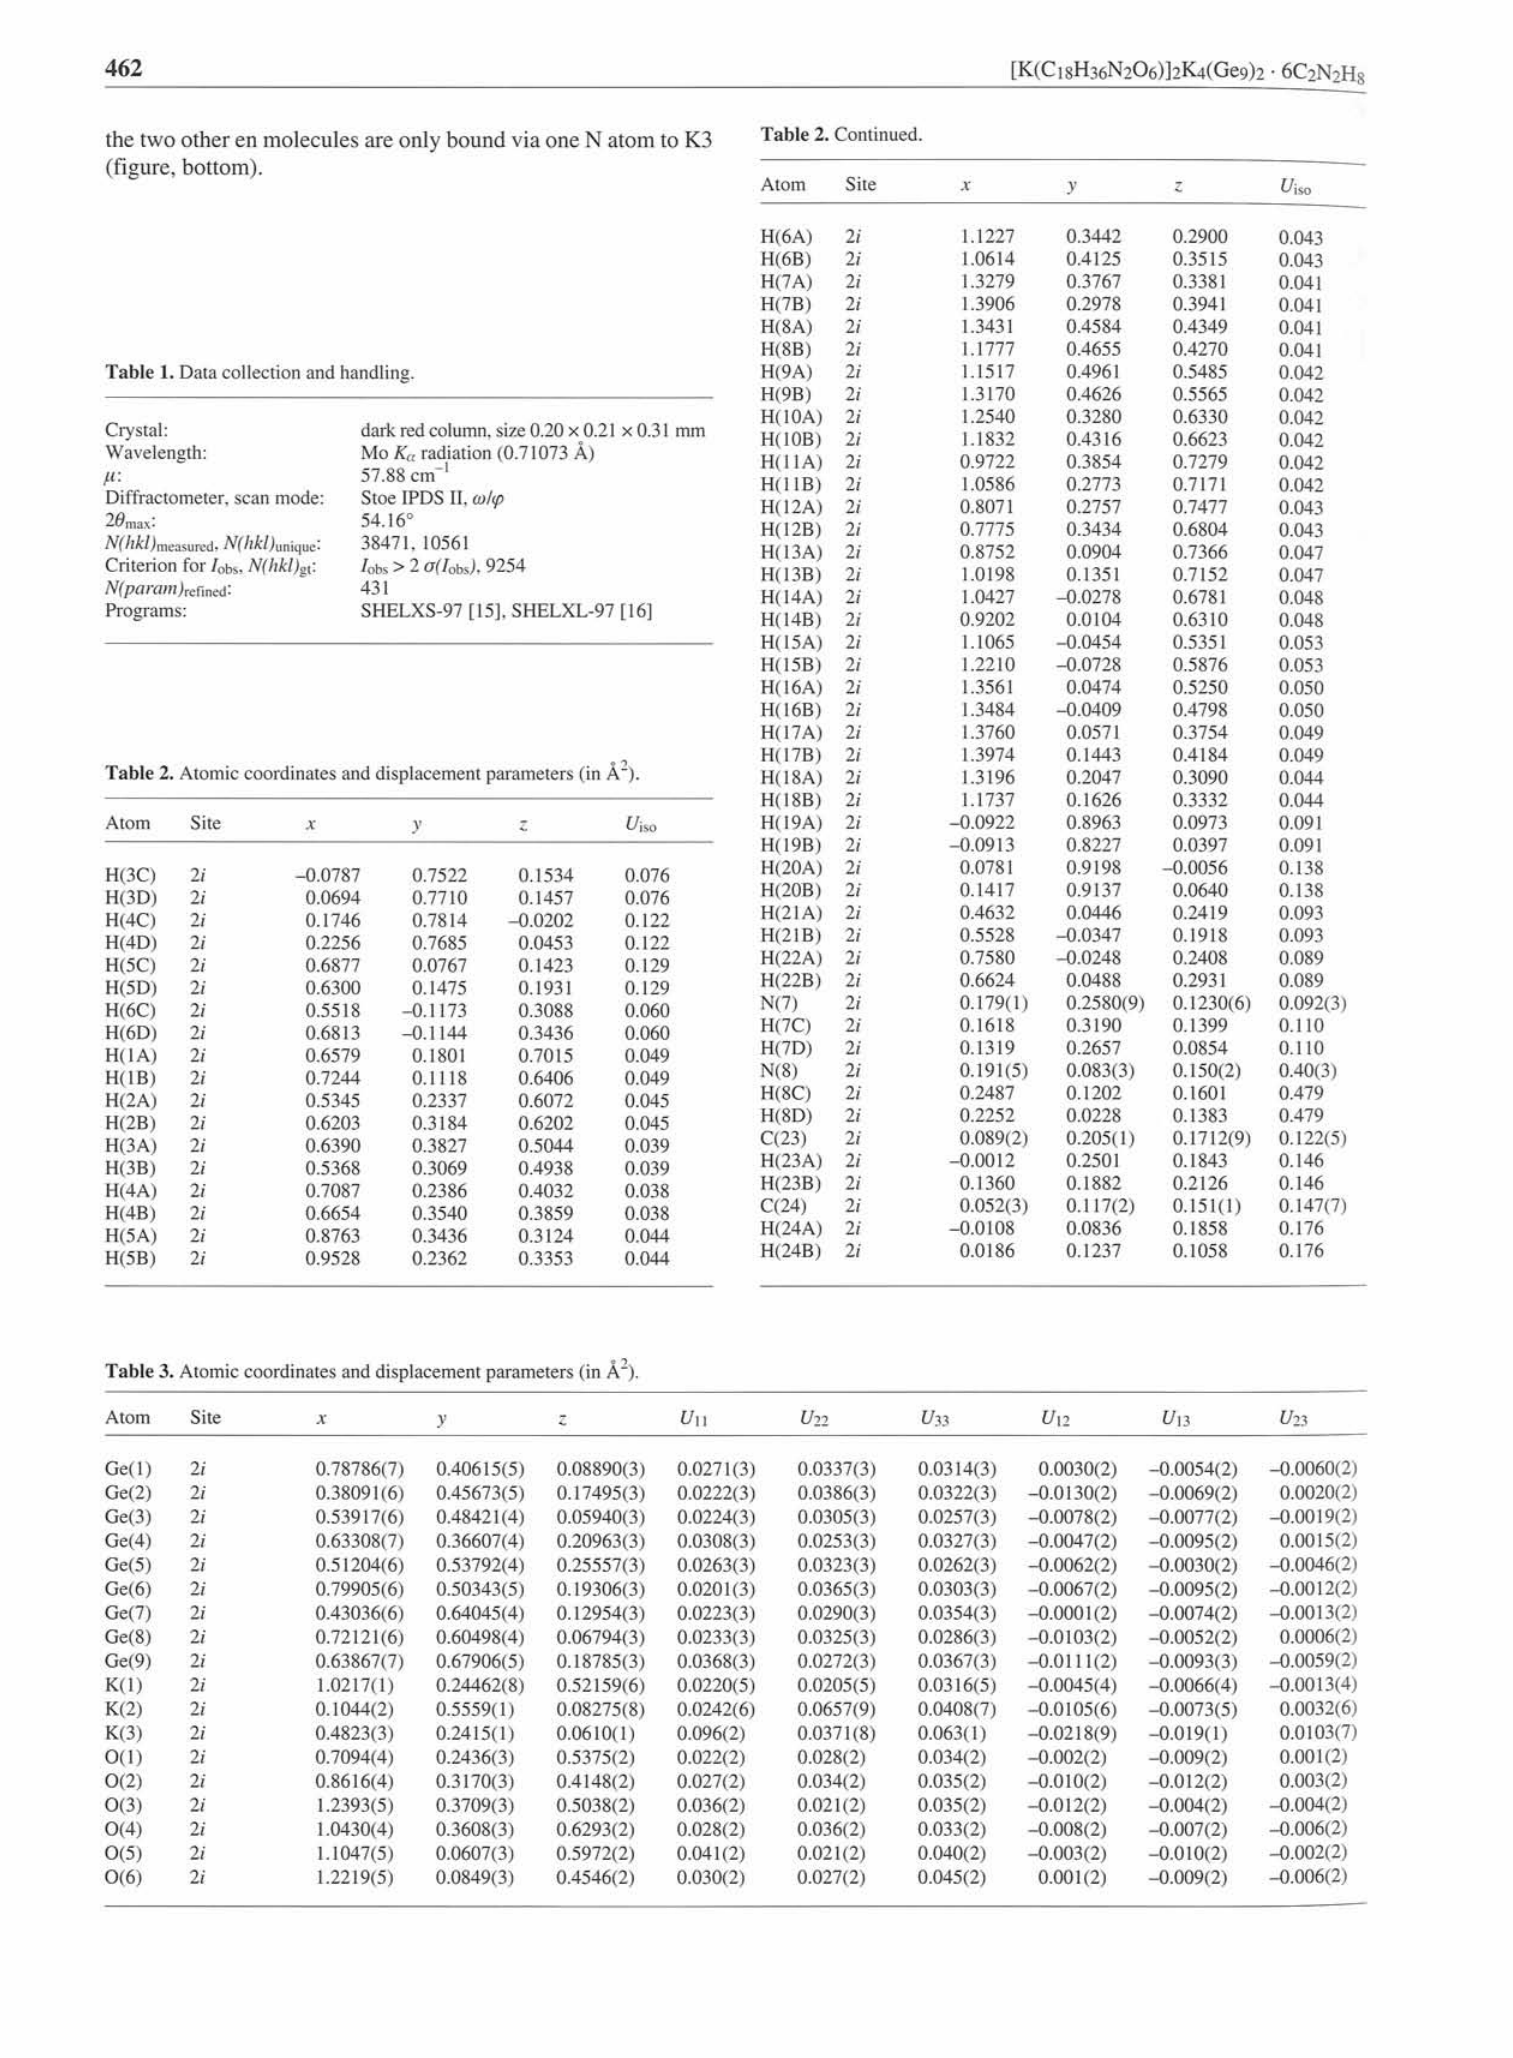
Table 1. Data collection and handling.